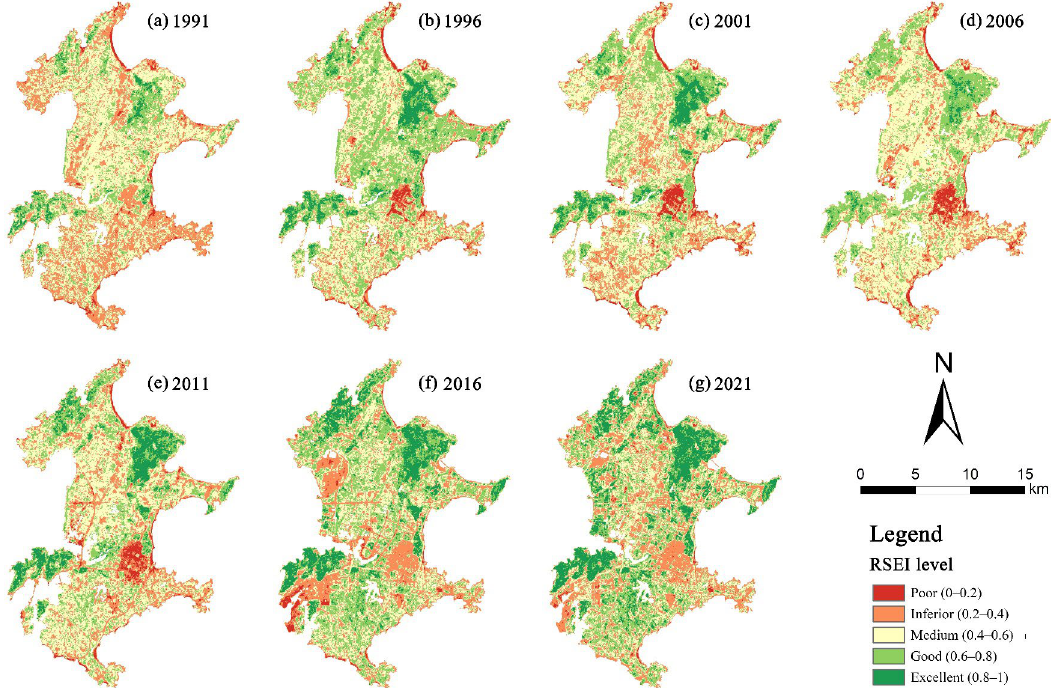
Figure 4. Example of five-leveled remote sensing-based ecological index (RSEI) images of Haitan Island. The different boundaries are due to reclamation. ( a ) RSEI in 1991; ( b ) RSEI in 1996; ( c ) RSEI in 2001; ( d ) RSEI in 2006; ( e ) RSEI in 2011; ( f ) RSEI in 2016; ( g ) RSEI in 2021.